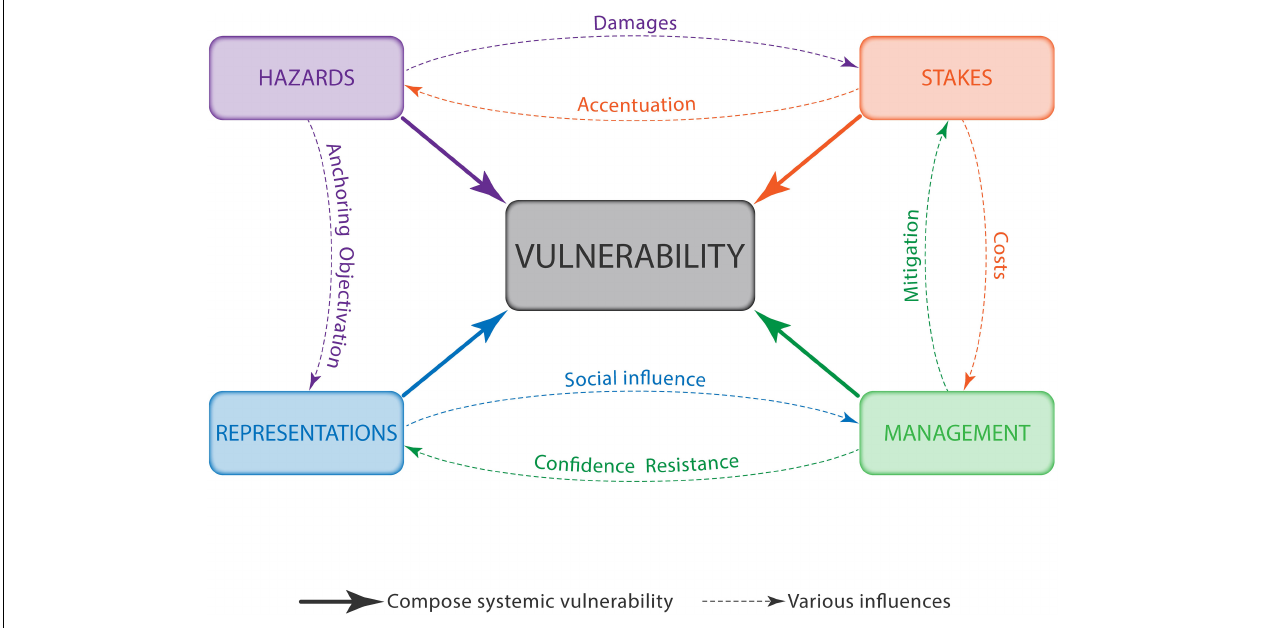
FIGURE 1 | Factors contributing to and interacting with vulnerability (Michel-Guillou and Meur-Féréc,